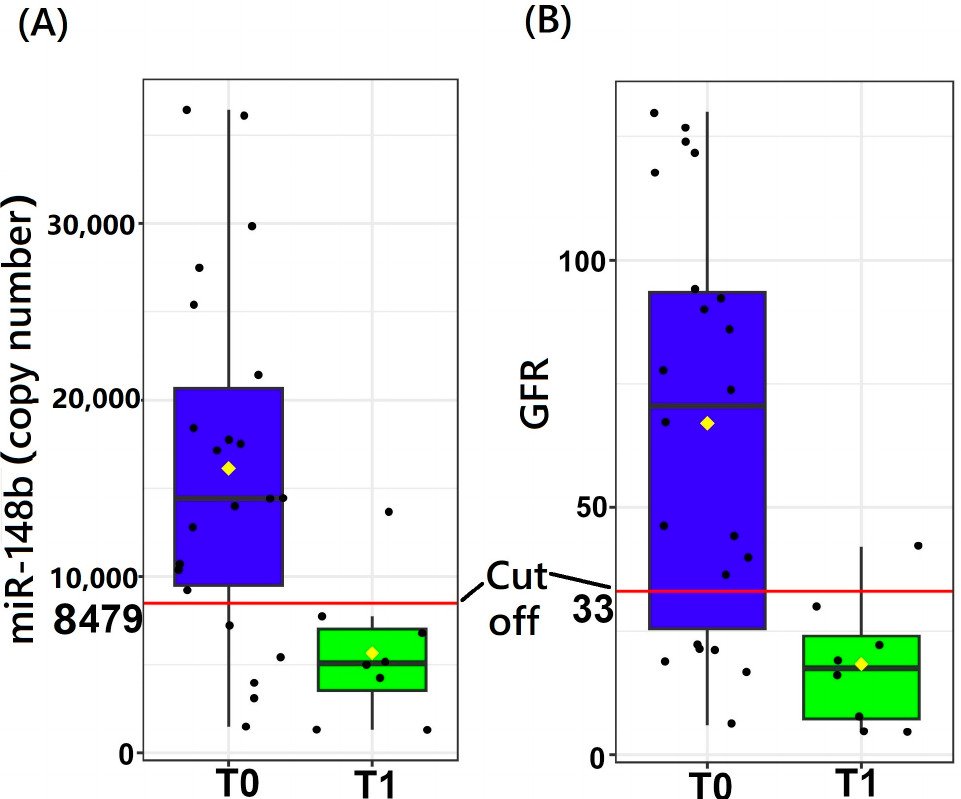
Figure 3. miR-148b and GFR in tubular atrophy/interstitial fibrosis states in IgAN. ( A ): miR-148b cutoff (threshold) level to differentiate IgAN severity based on T stage differentiation. ( B ): GFR cutoff (threshold) level to differentiate IgAN severity based on T stage differentiation. Threshold (cutoff) value estimated by a logistic regression model.